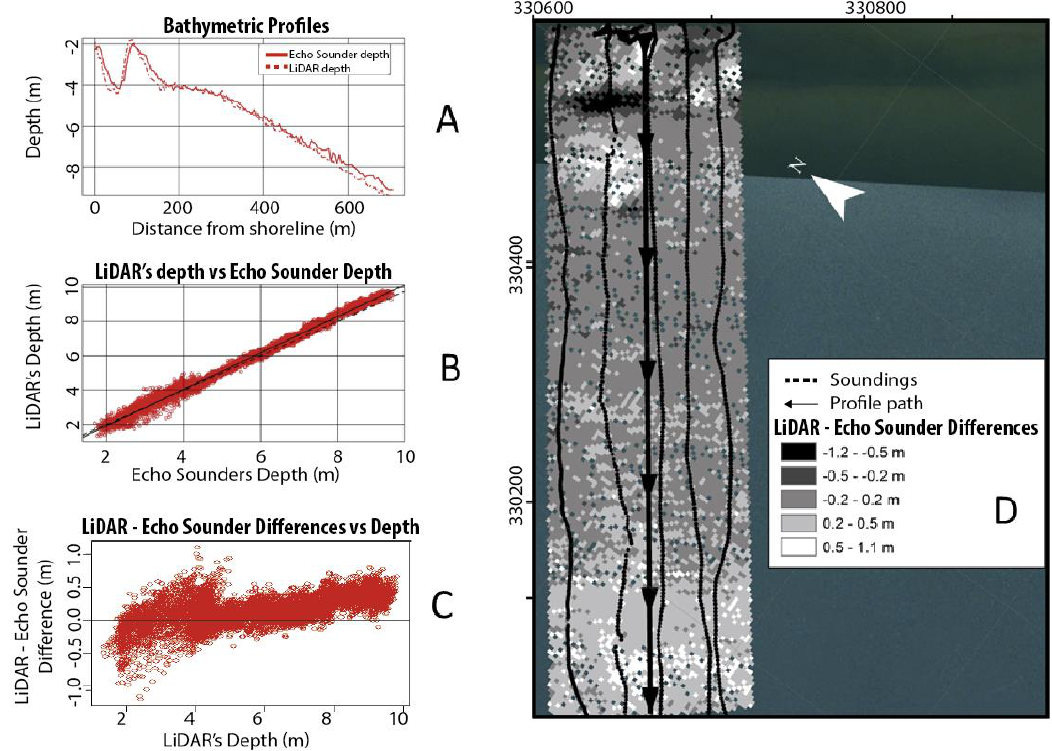
Figure 6. Performance and accuracy of the submerged LiDAR data compared with the single-beam acquisition ( A ) (top left). The comparison was carried out through a traditional assessments accuracy metrics, such as the differences. ( B ) (middle left) and ( C ) (bottom left) show, both the spatial resolution of the different measuring points of the seafloor (determined by differences in the acquisition system with single-beam and bathymetric LiDAR) and the scatter plot of the difference between the two interpolated DSM ( D ; right).